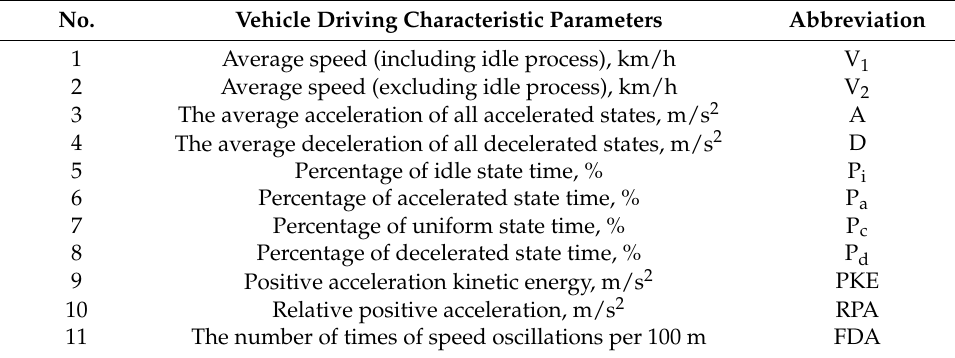
Table 2. The vehicular driving characteristic parameters.